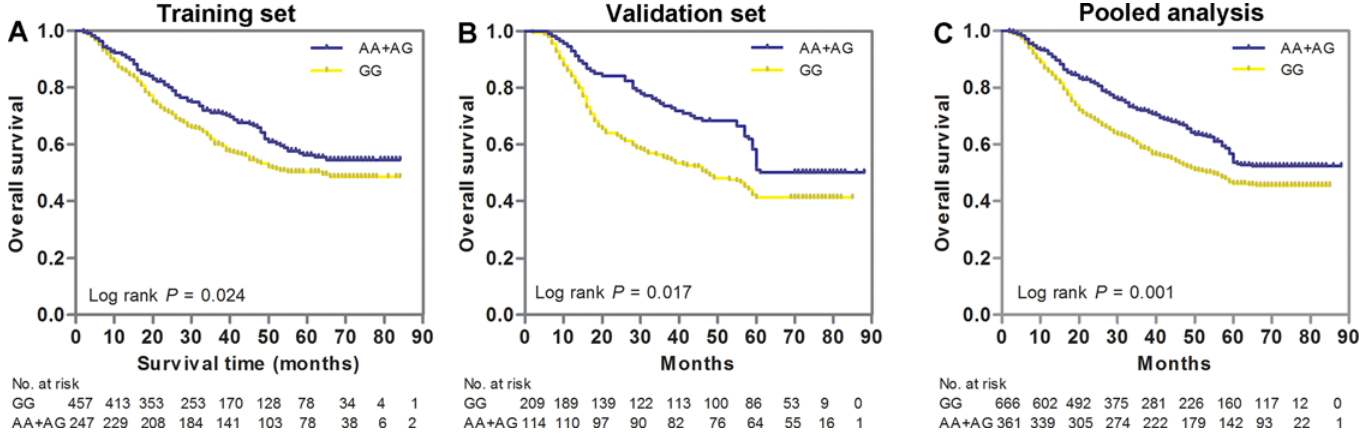
Fig 1. Kaplan-Meier estimates of overall survival (OS) for gastric cancer (GC) patients stratified by genetic variants of HMGB1 gene. OS of GC patients stratified by SNP rs1045411 in the training set (A), validation set(B) and pooled analysis(C). Patient numbers may not add up to 100% of available subjects because of missing genotyping